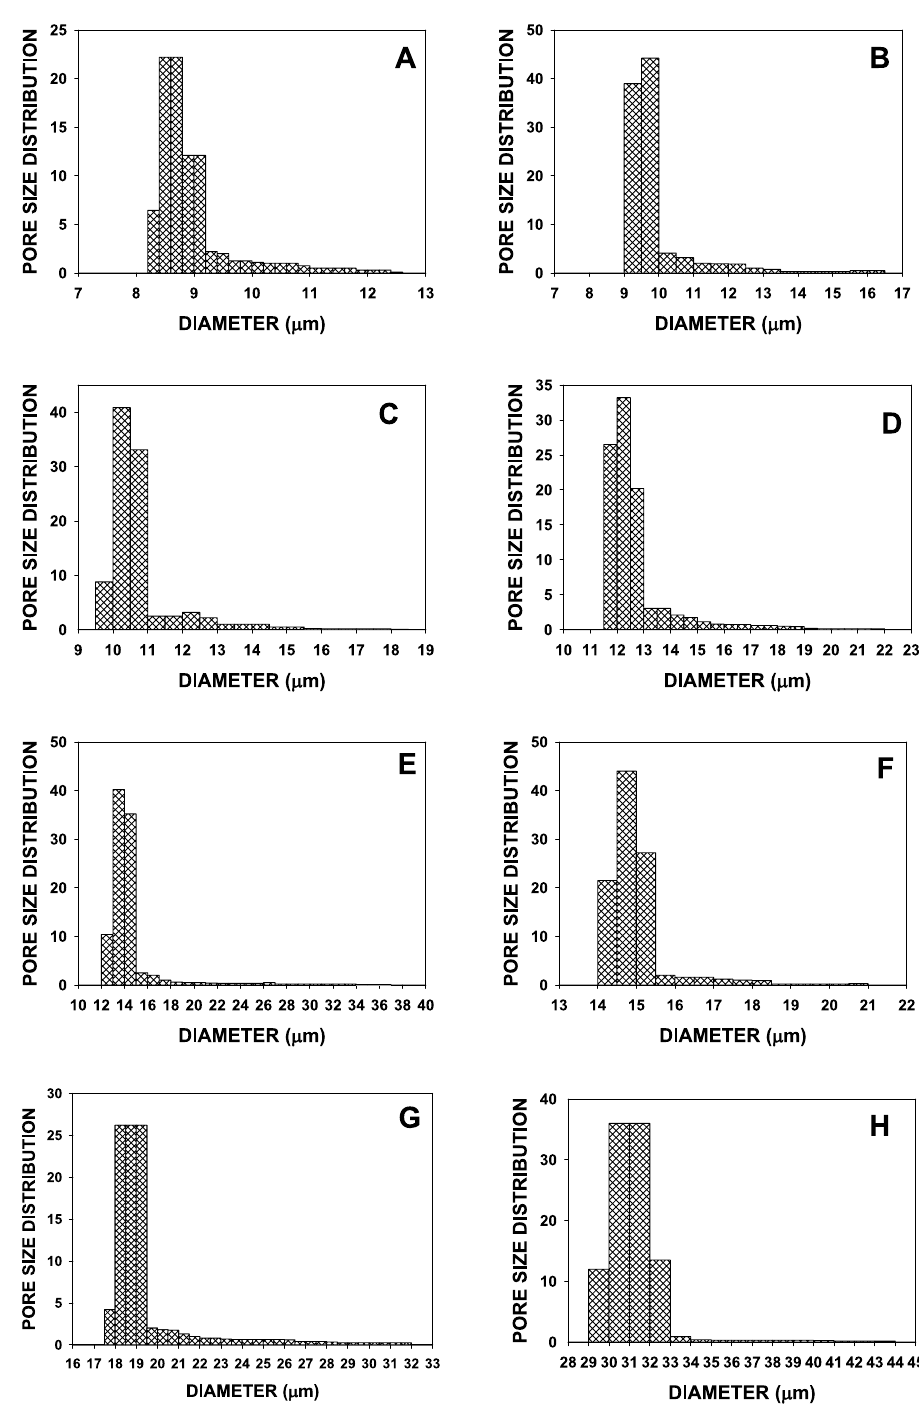
Figure 6. Pore size distribution of different sample (A–H) showing distribution of different diameter pore of the filter layer nonwoven PP-MB-NW fabric. ( A – H ) Plot showing pore size distribution vs. pore diameter of sample A, B, C, D, E, F, G and H using mercury